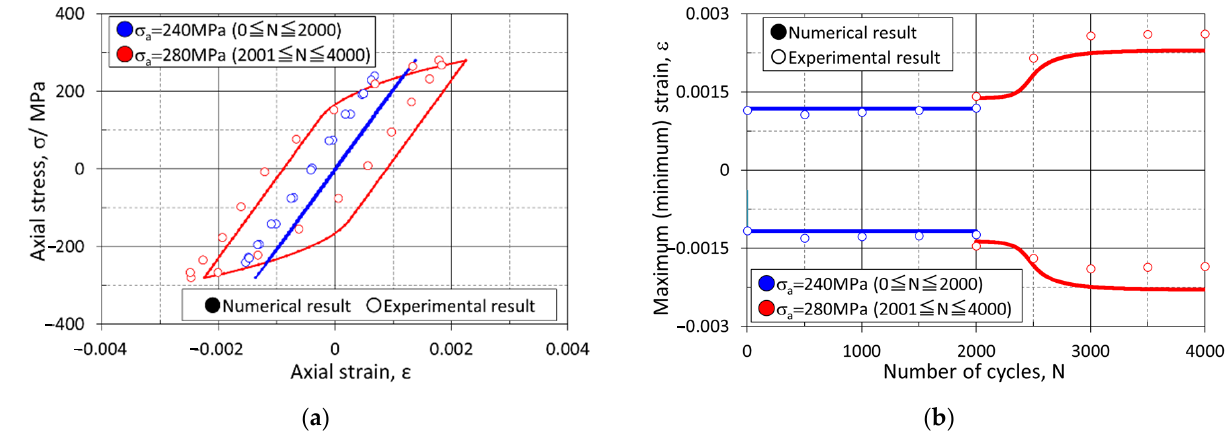
Figure 9. ( a ) Numerical stress and strain curves under two-step amplitude loading; ( b ) numerical relationships between ε max- ε min and the number of cycles under two-step amplitude loading.